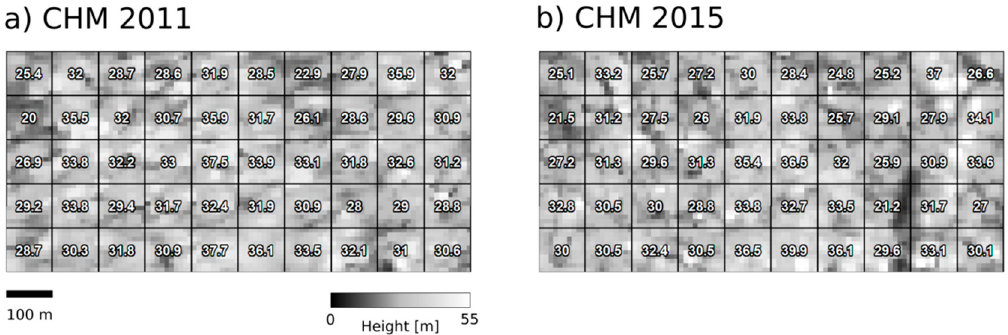
Figure A4. TanDEM-X-derived canopy height models (CHM) for the years 2011 ( a ) and 2015 ( b ). CHMs have 10 m pixel resolution and mean top-of-canopy height (TCH10) (m) was calculated at 1 ha scale (labels on maps).